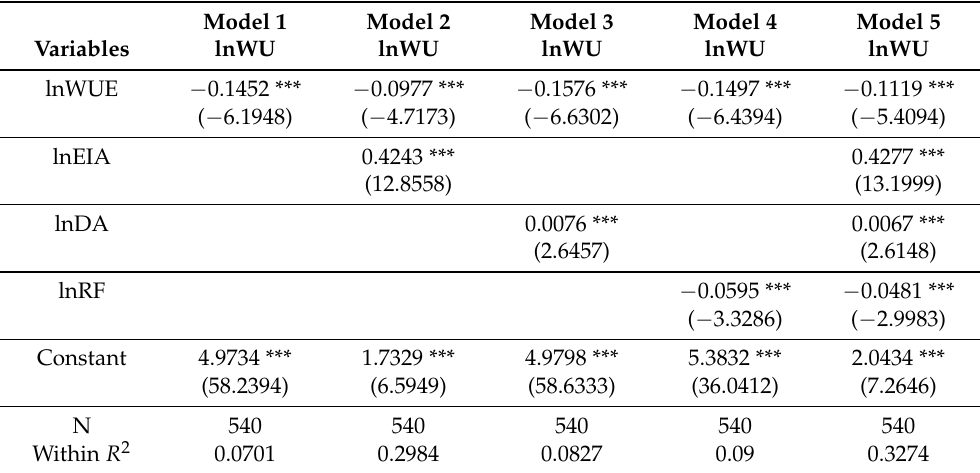
Table 3. Estimation